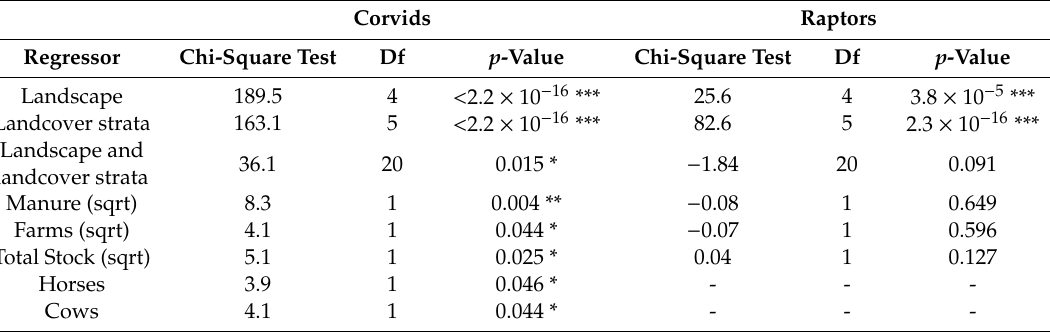
Table 4. Significance tests for regression parameters in the corvids and raptor avian predator